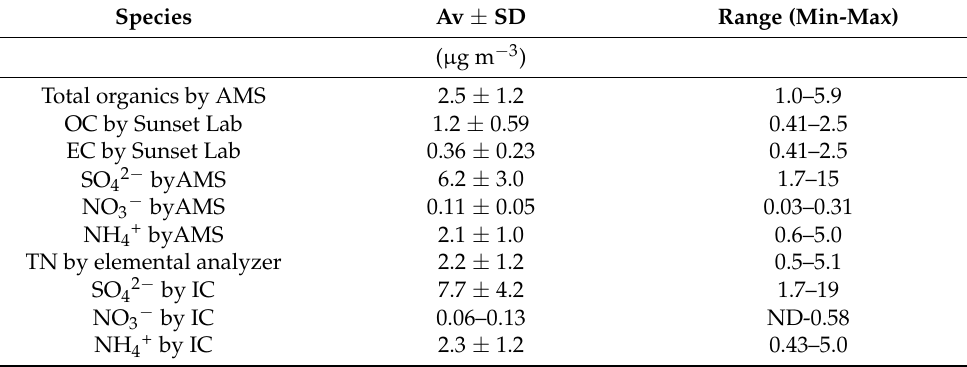
Table 1. Concentrations of organic and inorganic species measured by different methods during the same study